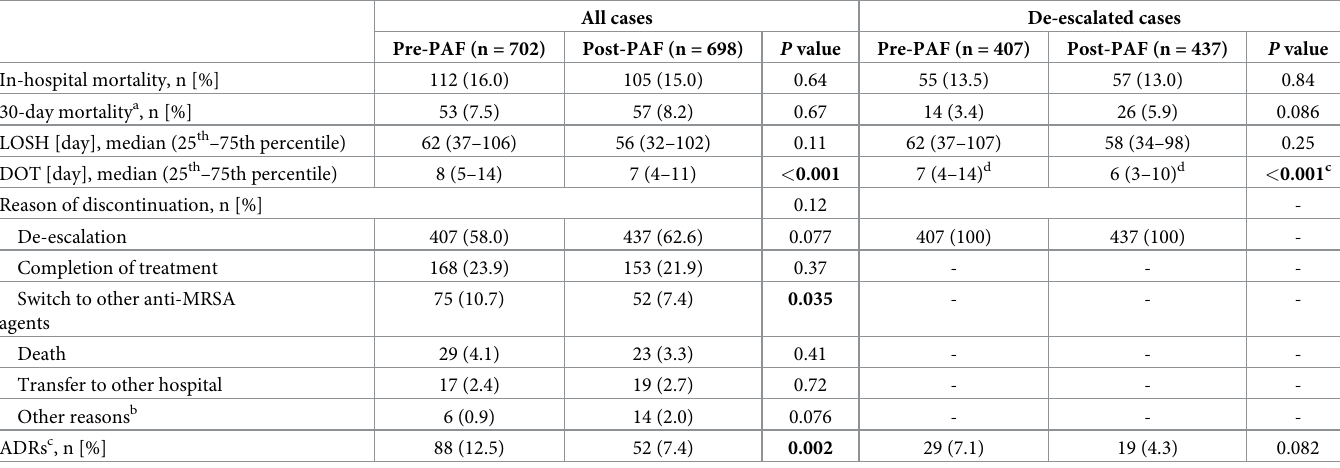
Table 4. Effects of PAF implementation on secondary clinical outcomes.